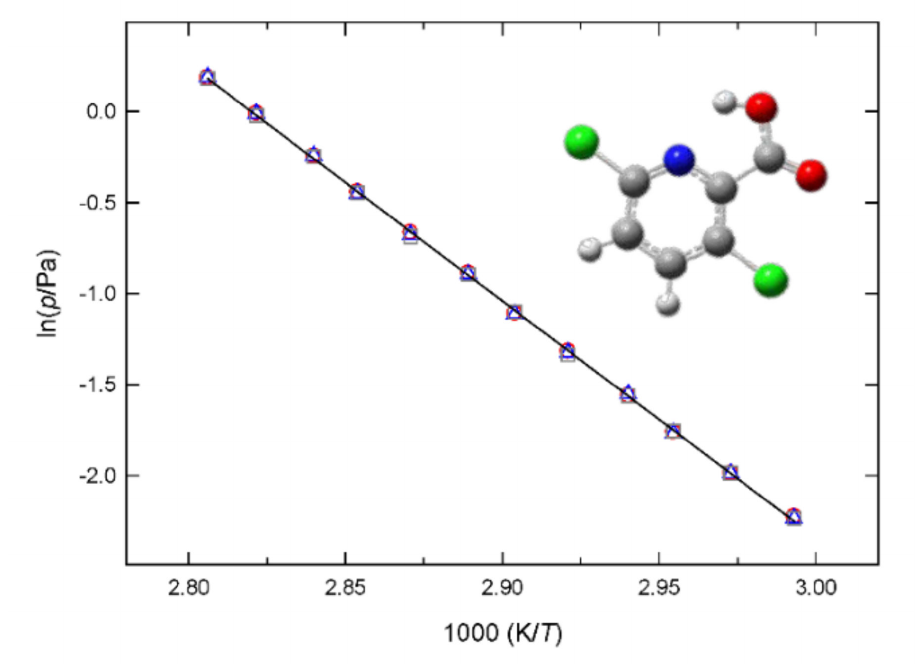
Figure 3. Plot of ln p against 1/ T for clopyralid. and (cid:3) , large effusion